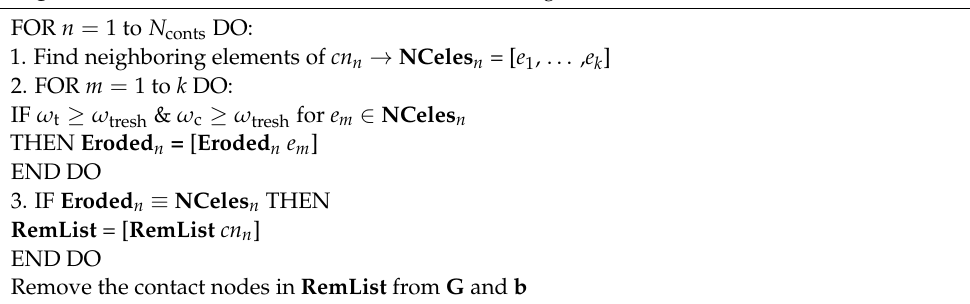
Algorithm 1: Pseudocode for contact node deletion